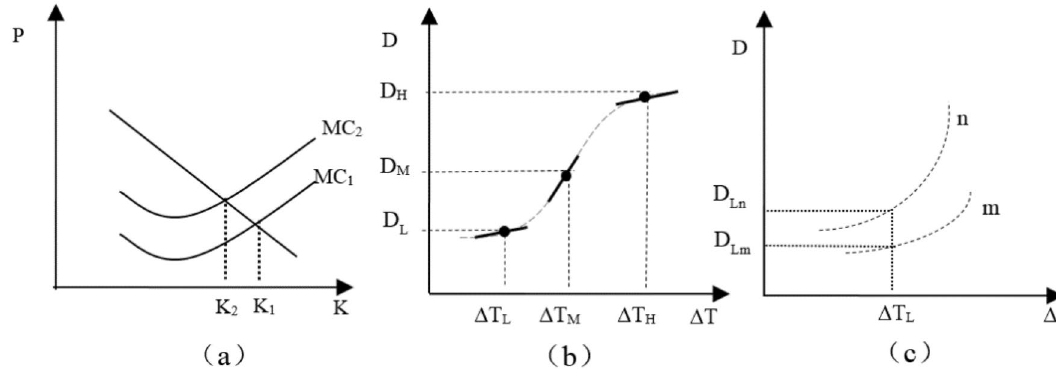
Figure 1. Differences in the marginal damage of temperature changes under different